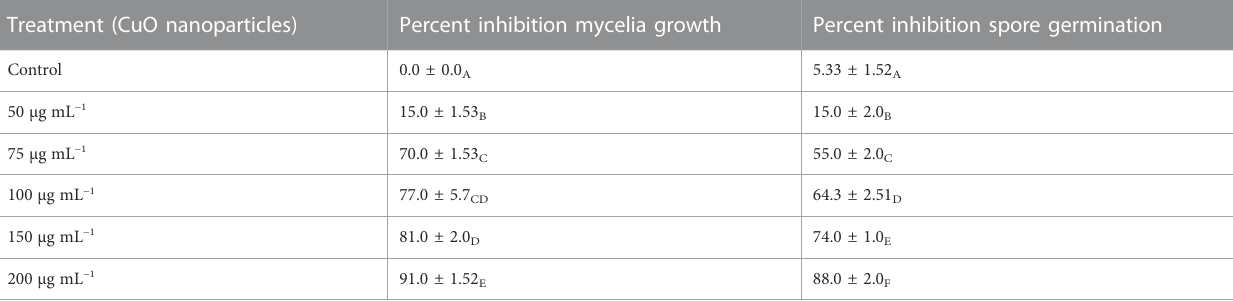
TABLE 1 Effect of varying concentrations of CuO nanoparticles on in vitro mycelial growth and spore germination of phytopathogenic fungi Alternaria sp. Treatment (CuO nanoparticles)